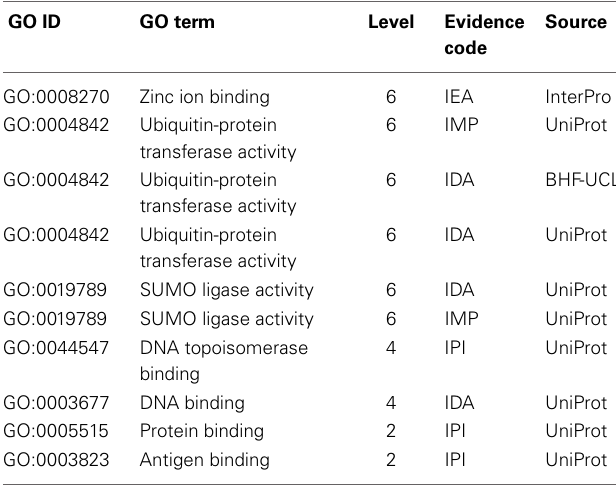
Table 1 | GO annotations of the protein E3 ubiquitin-protein ligase Topors